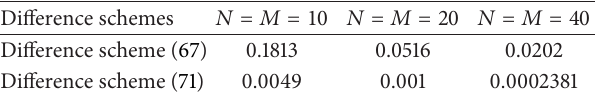
Table 2: Errors for the approximate solution of problem (87). Difference schemes